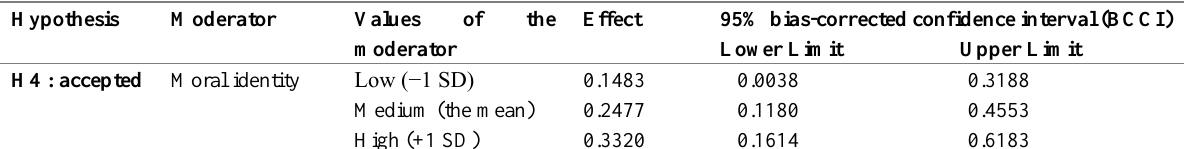
Table 7: Moderated mediation.